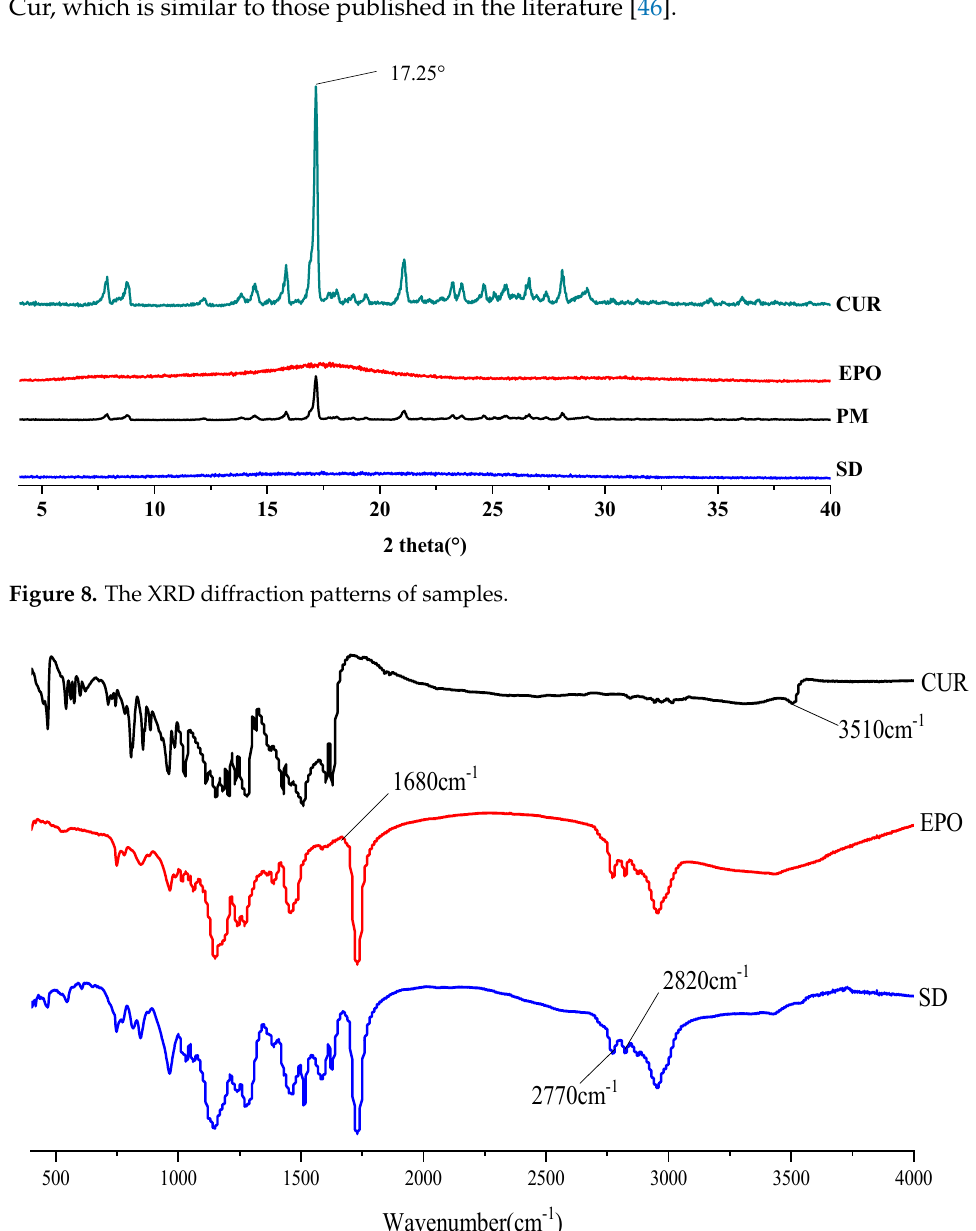
Figure 7. The DSC curves of the samples.